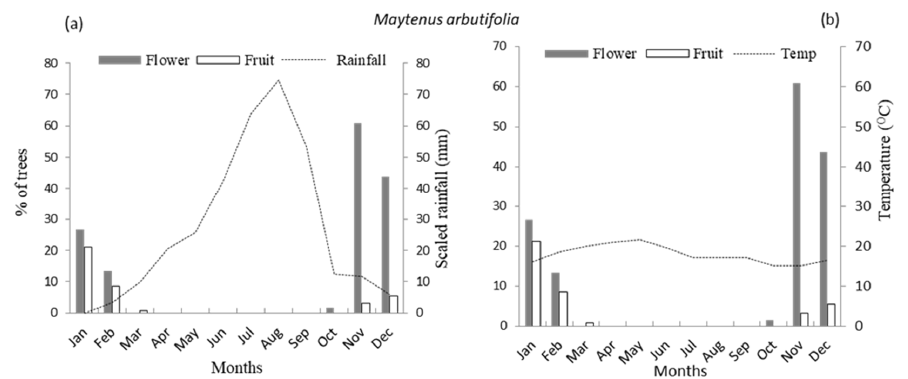
Figure 5. Percentage of flowering and fruiting of Maytenus arbutifolia , in relation to: ( a ) monthly precipitation and ( b ) average temperature. In which Jan = January, Feb = February, Mar = March, Apr = April, May = May, Jun = June, Jul = July, Aug = August, Sep = September, Oct = October, Nov = November, Dec = December.